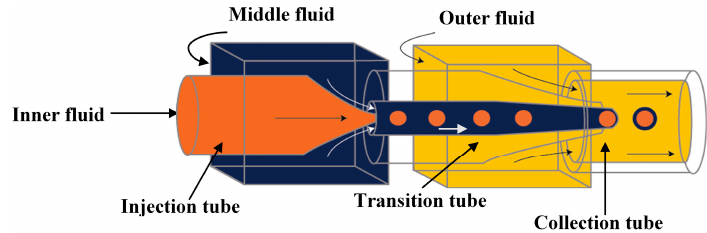
Figure 12. A schematic diagram of coaxially assembled glass capillaries on glass slides consisted of